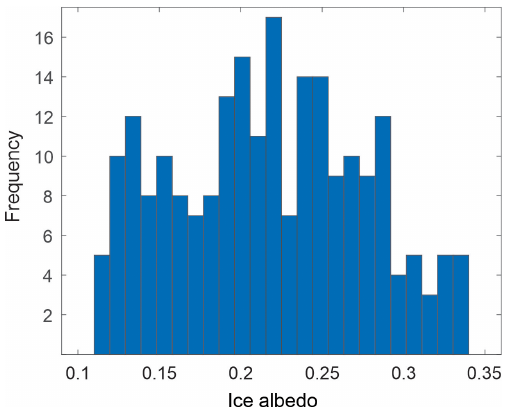
Figure 5. Distribution of daily mean ice-albedo values recorded at the Haig Glacier AWS from the summers (JJA) of 2002 to 2015 for all days that were snow-free at the AWS site ( N =